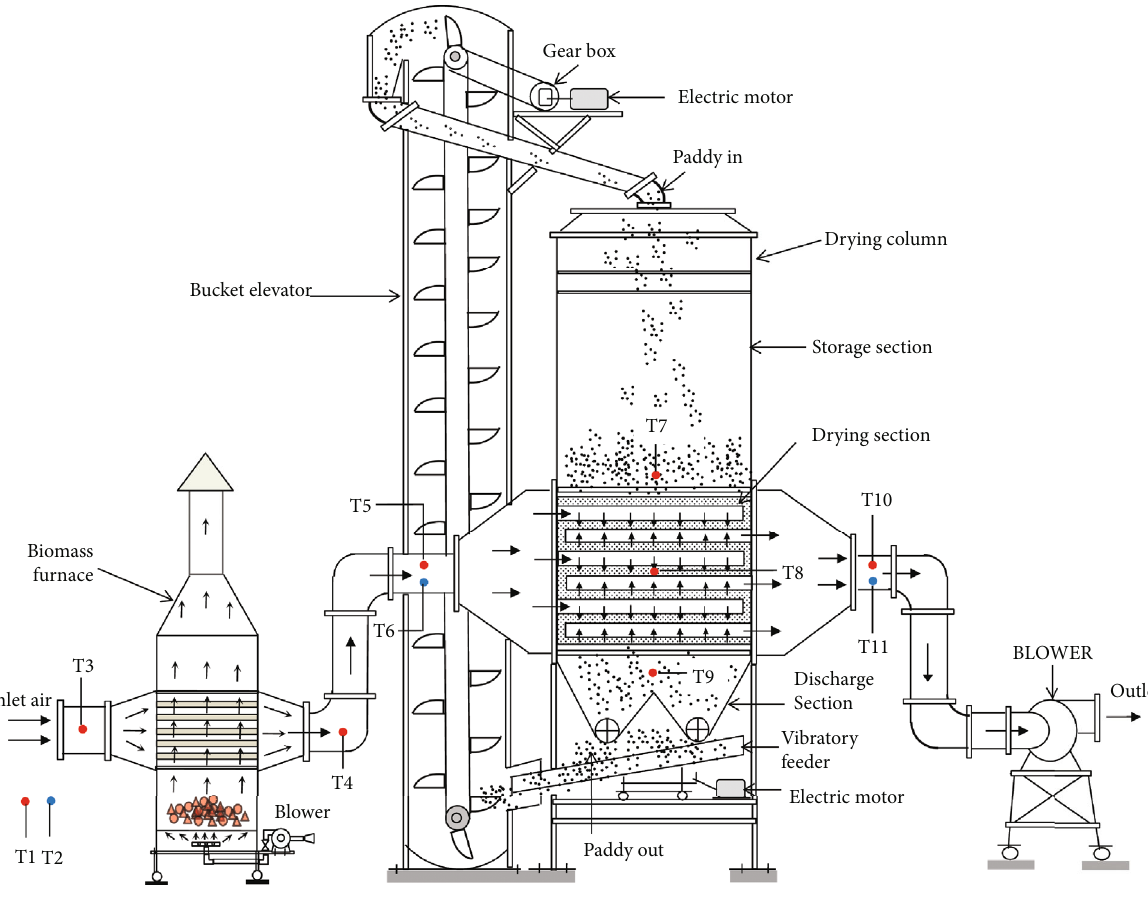
Figure 2: Schematic of the PSBA-RMFD.